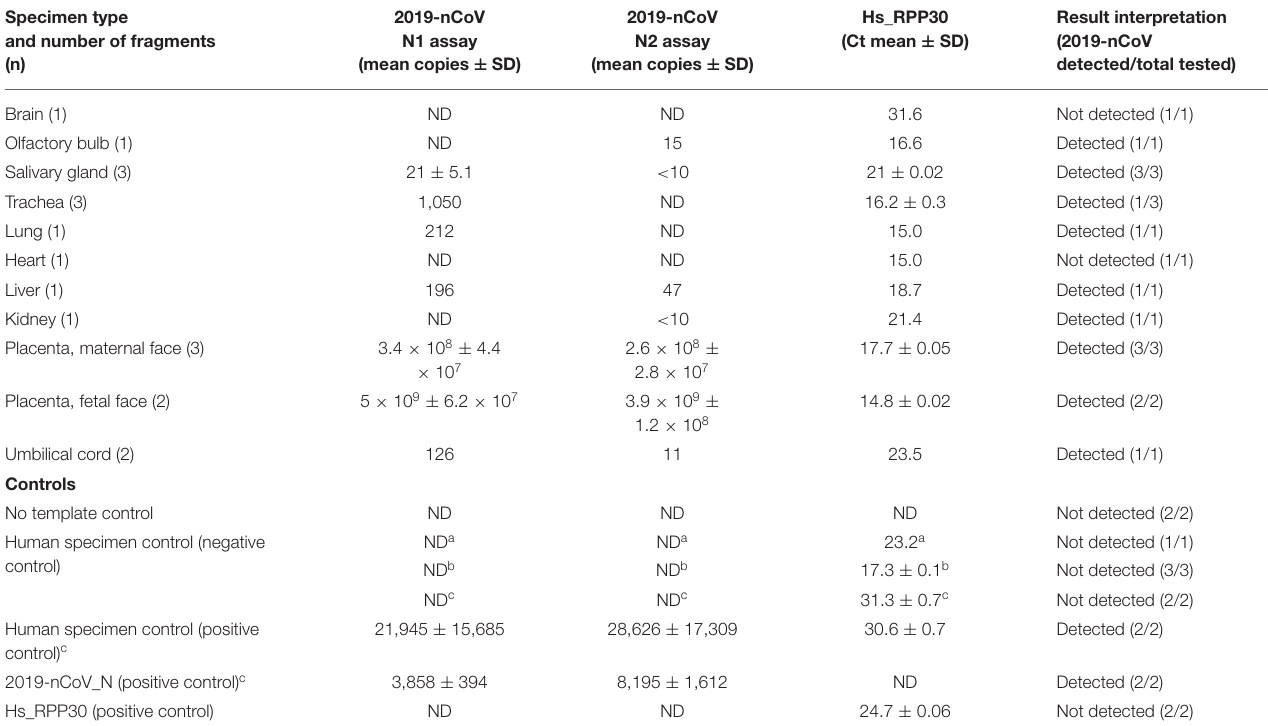
TABLE 2 | RT-qPCR detection of SARS-CoV-2 in the fetal tissues. Specimen type and number of